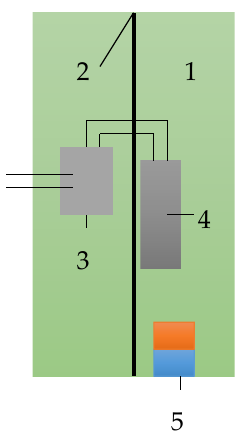
Figure 3. Sensor design: 1 is the sensor casing, 2 is the supporting bar, 3 is the PCB of the comparator, 4 is the ME element, and 5 is the permanent magnet.